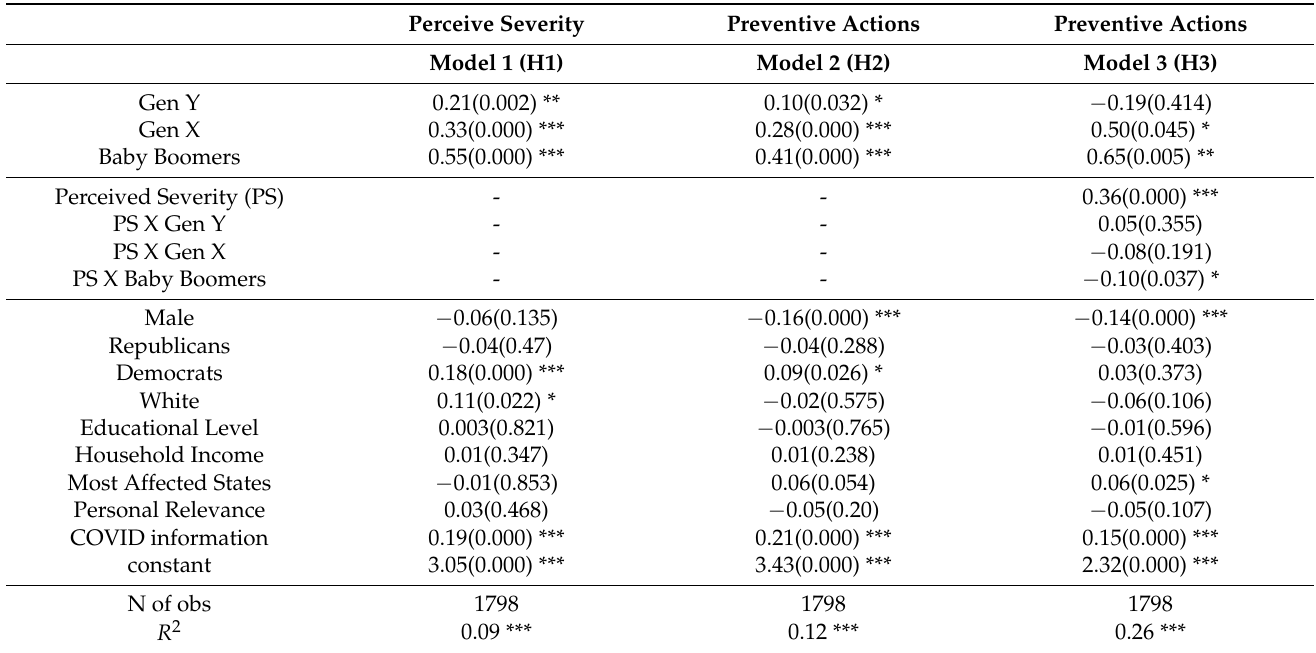
Table 3. Linear Regression Models Predicting Perceive Severity and Preventive